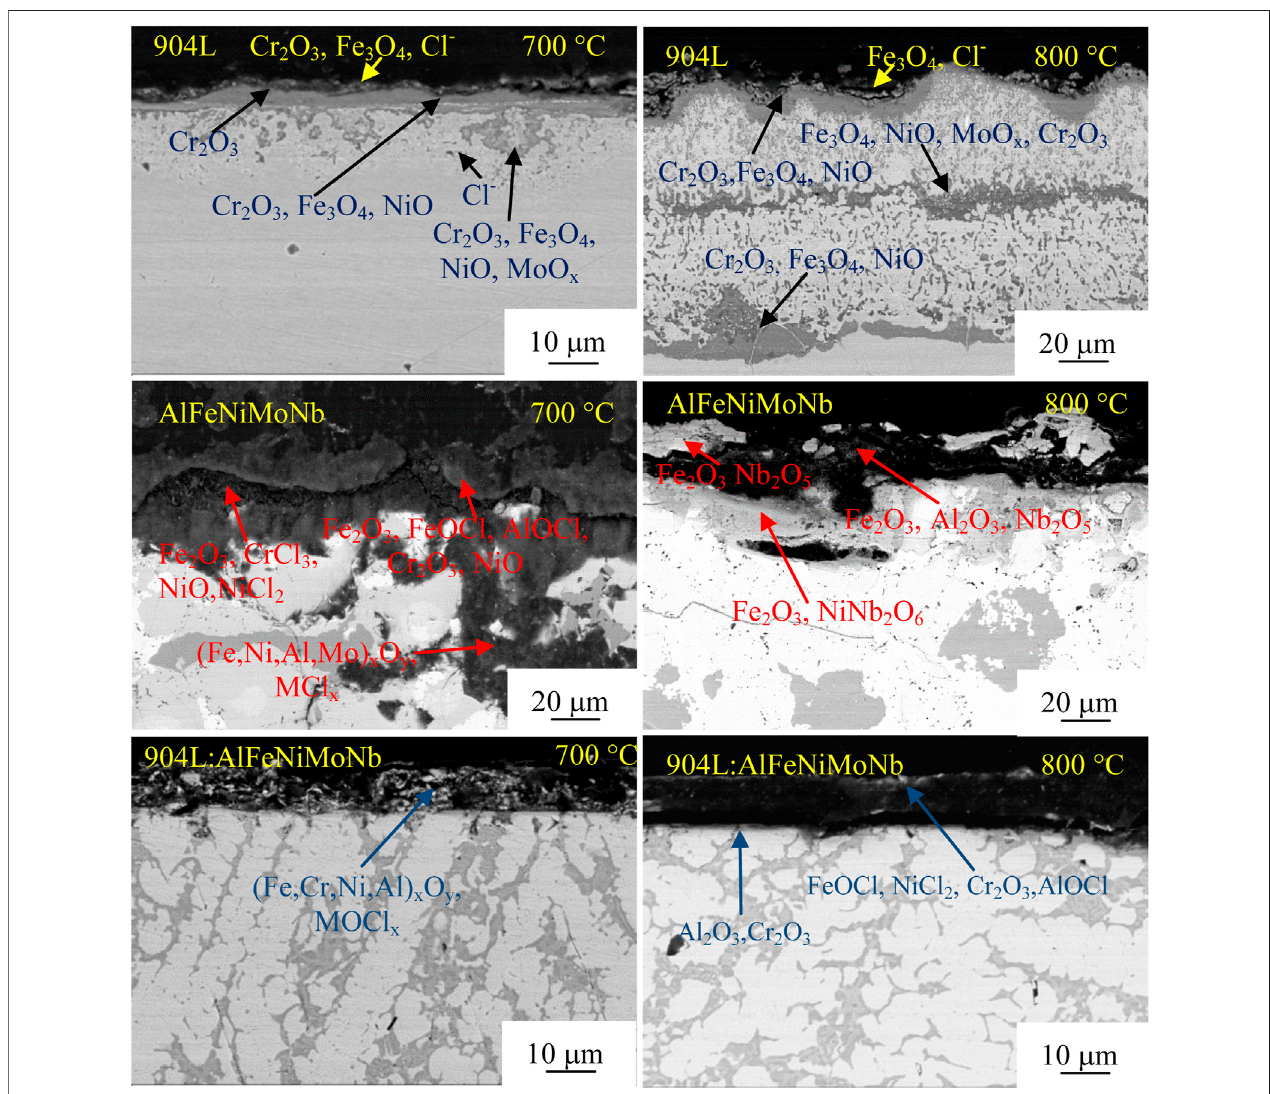
FIGURE 14 | Cross-section morphology and composition of the corroded samples corroded under N 2 – 2.6 vol.% CO 2 – 1.3 vol.% O 2 – 2,700 vppm HCl gaseous environment at 700 ° C and 800 ° C for 55 h.